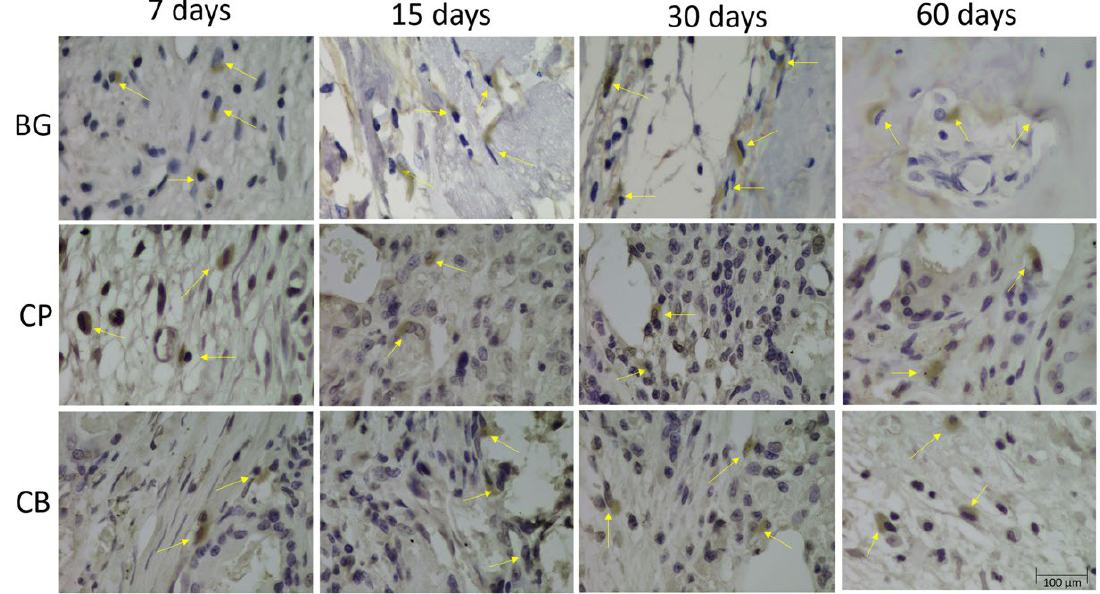
Figure 5. Photomicrographs of groups BG, CP and CB, during the bone repair periods at 100× mag- nifications, showing osteocalcin immunostaining (yellow arrows).